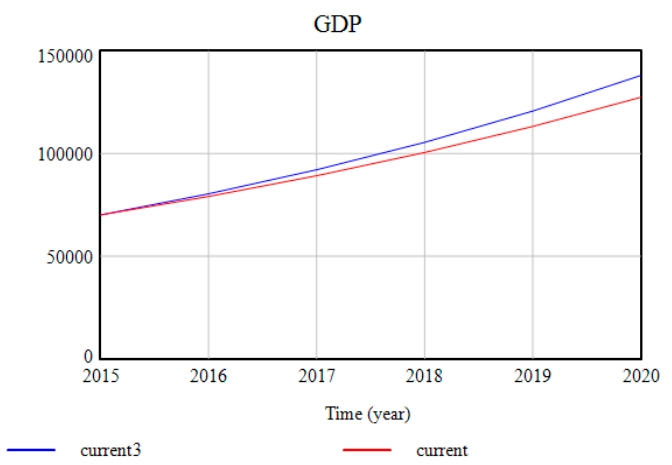
make decisions in accordance with the local economic development. From the perspective